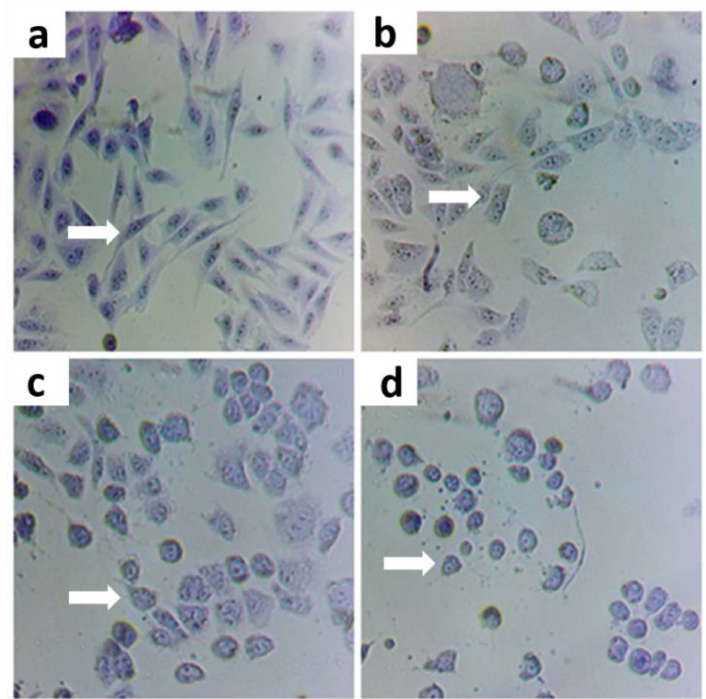
Figure 1. Effect of As as Negative control ( a ) with positive controls of As 5 ppm ( b ), As 10 ppm ( c ), and 20 ppm ( d ) concentration on CHO-K1 cell morphology. Image taken with a camera under a 200 × optical